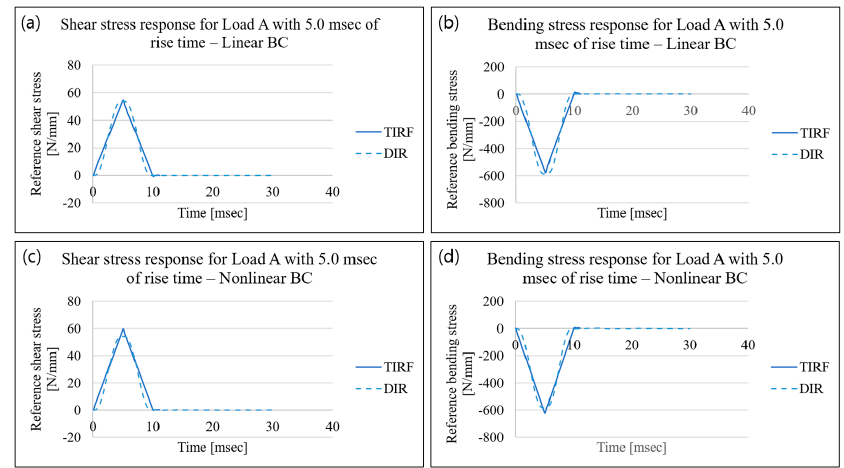
Figure 14. Reference shear and bending responses for Load A (1 × 1 load case) using TIRF and DIR for impact pressure of 5.0 ms of rise time: ( a ) Reference shear responses with linear boundary conditions, ( b ) Reference bending responses with linear boundary conditions, ( c ) Reference shear responses with nonlinear boundary conditions, and ( d ) Reference bending responses with nonlinear boundary conditions. Table 6. Shear responses for LNG cargo containment boxes (Model 2).